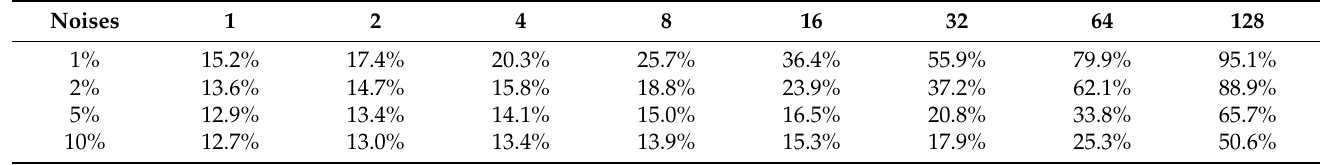
Table 5. Detection results of the time-considered CNN within the background with connected noises.